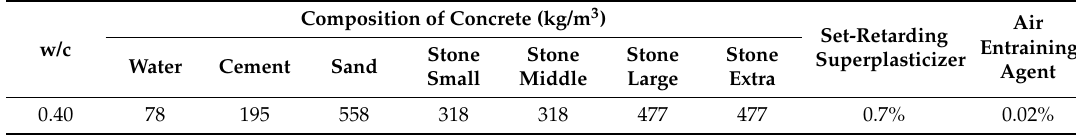
Table 5. Mix proportions of SSC concrete.